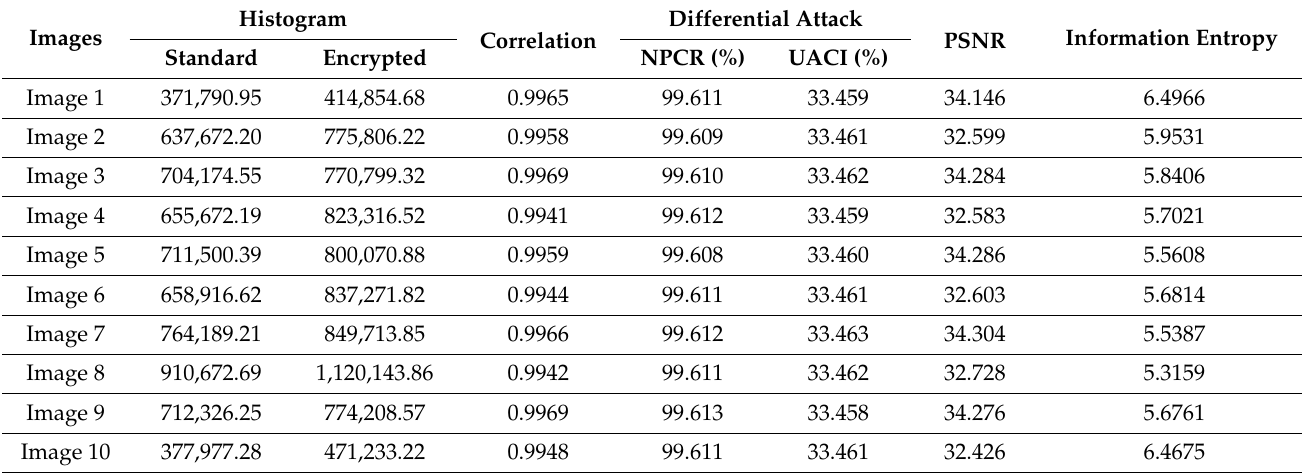
Table 2. Statistical metrics for CT Modality (Gaussian noise with 0.001 variance).